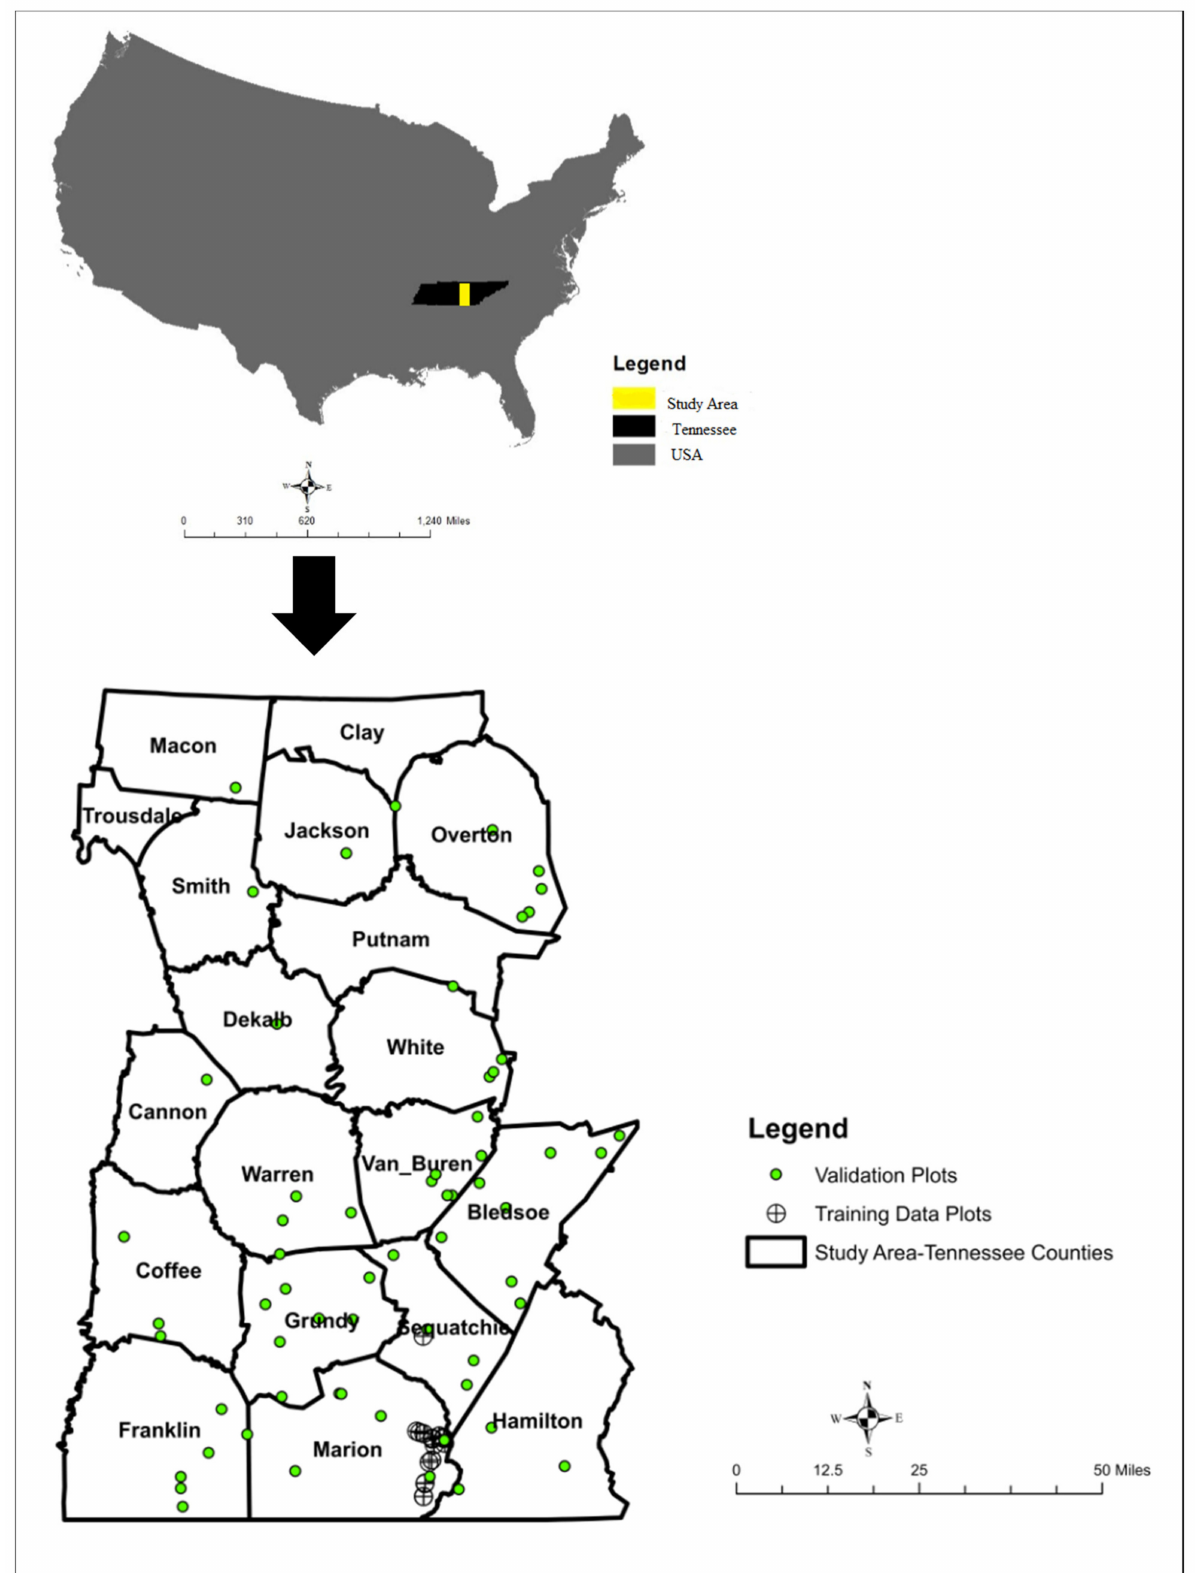
Figure 1. Study area consisting of 19 counties in Tennessee,